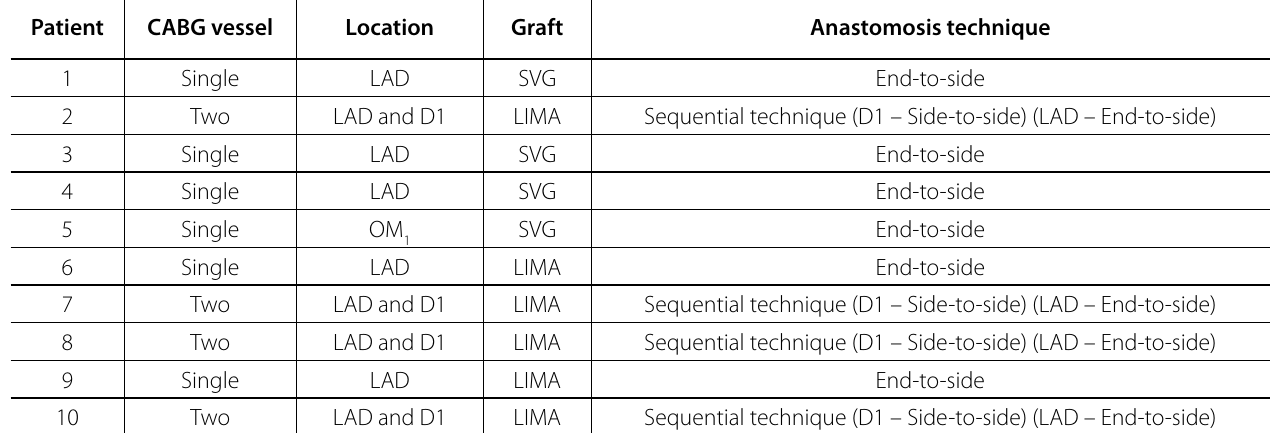
Table 3 . Revascularization characteristics of the patients.